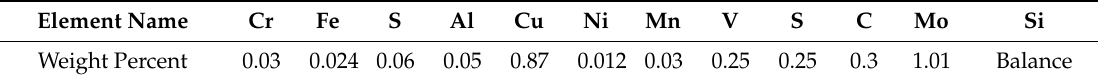
Table 1. Chemical composition of AISI 4130 steel (Wt.%).